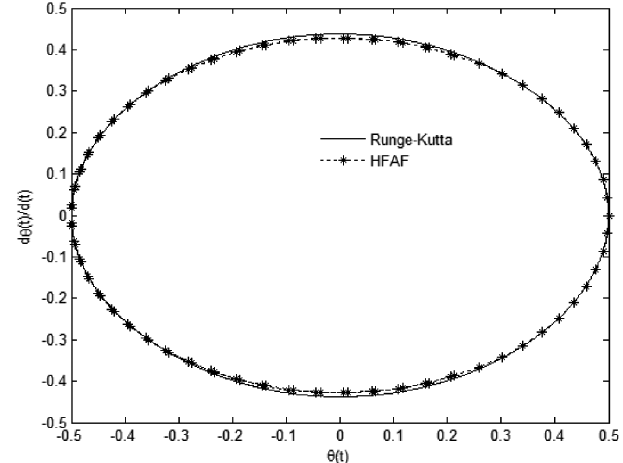
Fig. 3. The comparison between frequency-amplitude formulation with Runge-Kutta 4 th order for second mode, when A = 1.